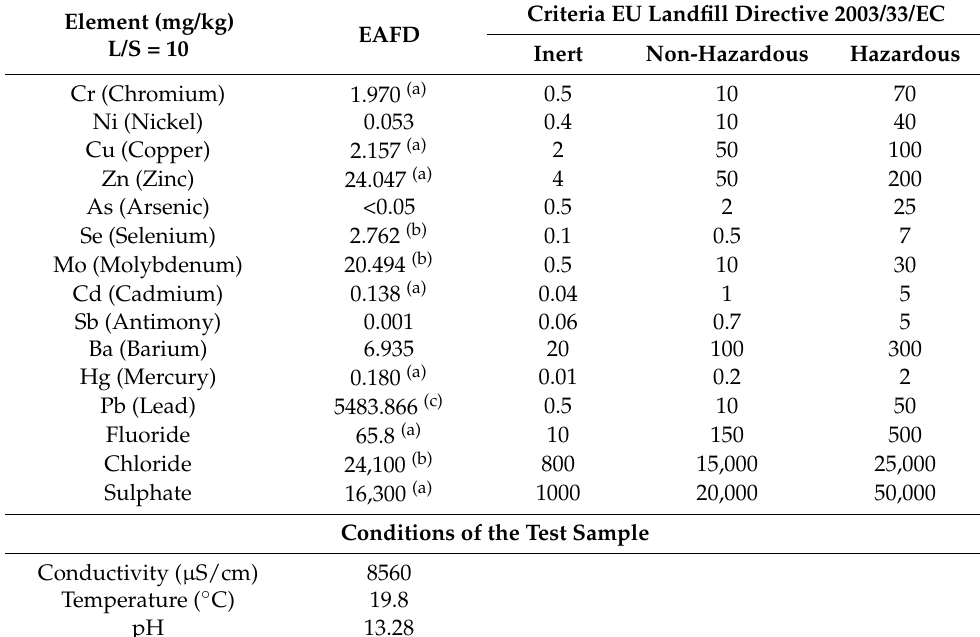
Table 4. Leached concentrations of EAFD (mg/kg) and acceptance criteria (WAC, EU Council Decision